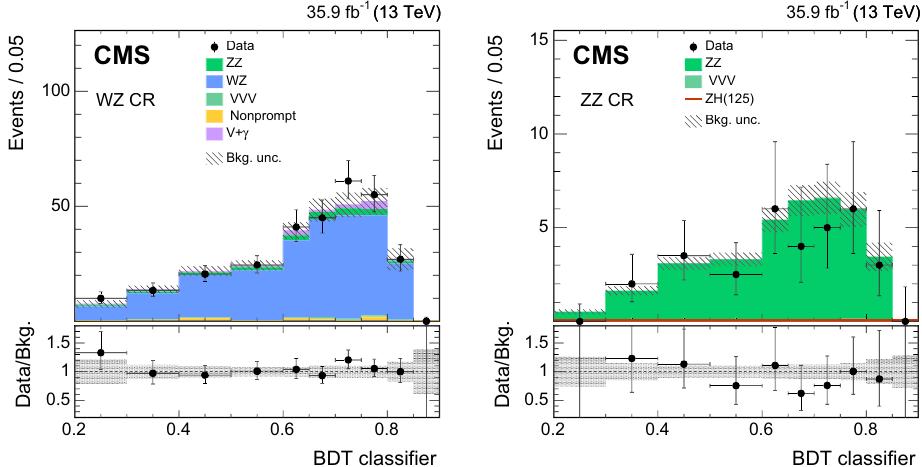
Fig. 3 DistributionoftheBDTclassifierinthedibosonCRs:(left)WZCR;(right)ZZCR.Uncertaintybandscorrespond tothecombinedstatistical and systematic components regions with inverted selections on Δφ( (cid:8) p (cid:2)(cid:2) | p miss